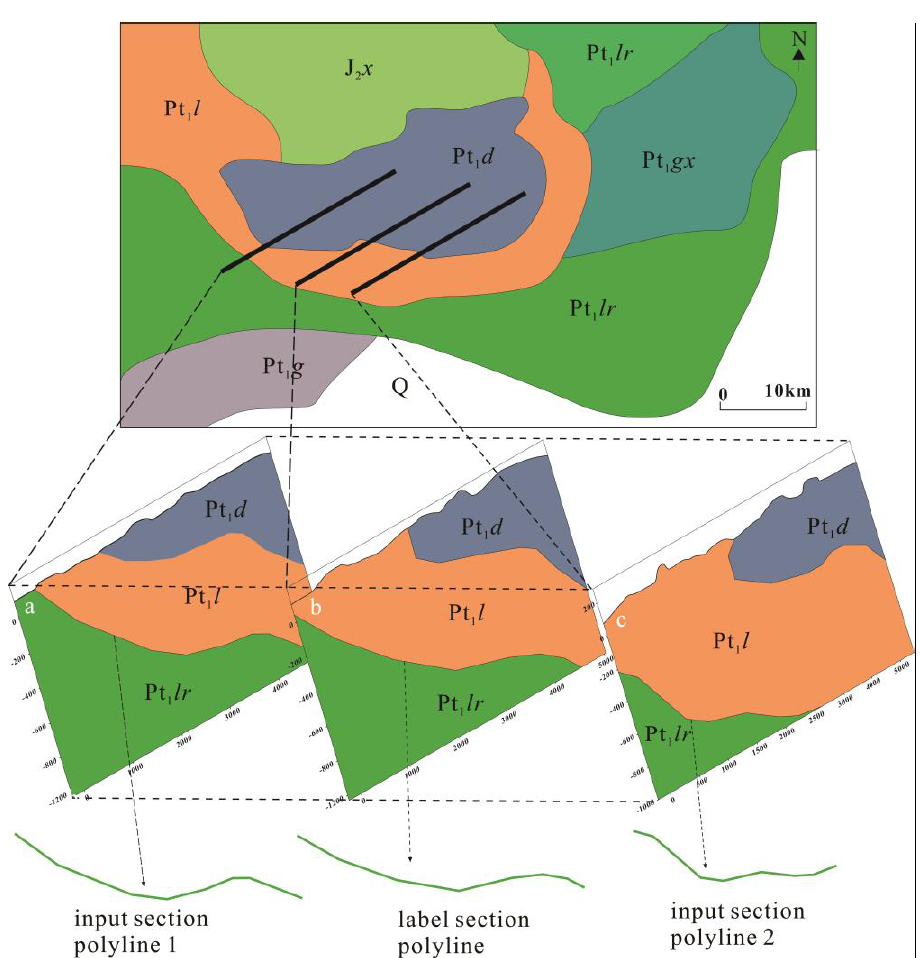
Figure 6. Examples of training dataset. ( a ) input section 1; ( b ) label section; ( c ) input section 2.